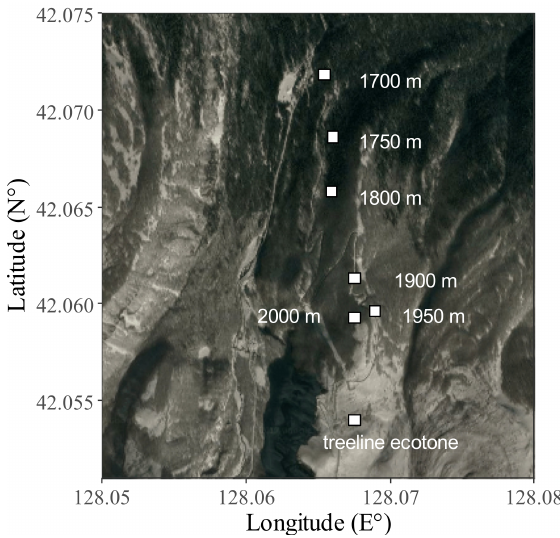
Figure 1. Study sites on the north-facing slope of Changbai Mountain, Northeast China. Data source: Google Earth.